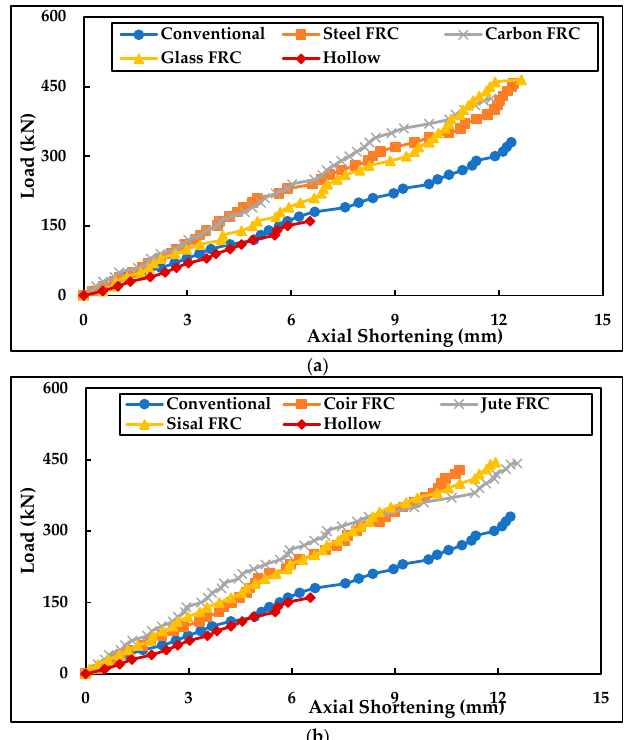
Figure 16. Graphical illustration of load vs. axial shortening of stub column. ( a ) Artificial FRC. ( b ) Natural FRC.